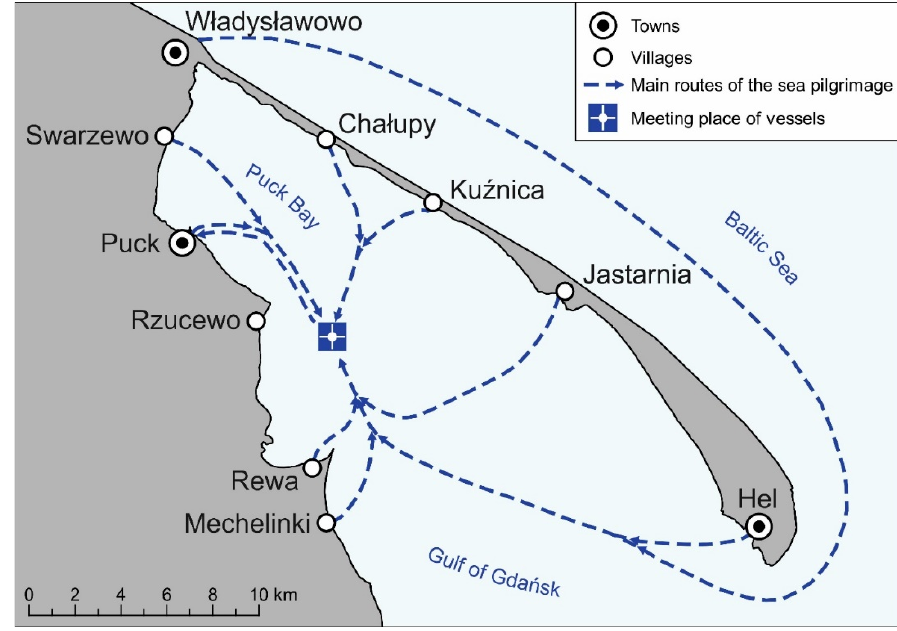
Figure 1. The route of the annual Fishermen’s Sea Pilgrimage. Source: authors’ elaboration. The number of vessels participating in the pilgrimage in individual years varied depending on the political and weather conditions (Turzy´nski 2006), and recently also due to the pandemic. The smallest numbers were recorded in the years of martial law (1982–1983) and during the COVID-19 pandemic (2020). Typical vessels taking part in the sea pilgrimage are presented in Figure 2. The largest numbers of fishing boats participating in the pilgrimages were recorded in 1991–1992, 1997–1998, and 2010, exceeding 50. In other years, the number ranged from 30 to 50. The fishing boat Magdalena (Figure 3 on the right) usually carried over 40 people. Slightly fewer boats took part in the pilgrimages organised in the second decade of the 21st century (Huras and Necel 2021). It is difficult to establish the number of all pilgrims in individual years, but it can be assumed that in the years in which over 50 vessels took part, the number of participants might have reached 1200 people.